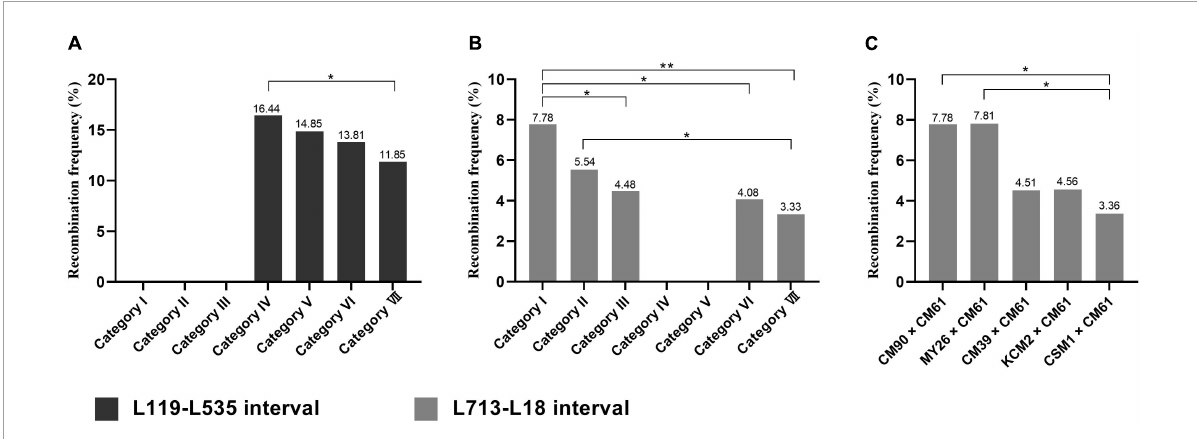
FIGURE4 Recombination frequency of 5A chromosome in L119-L535 and L713-L18 intervals. (A) Recombination frequency of 5A chromosome in L119-L535 interval. (B,C) Recombination frequency of 5A chromosome in L713-L18 interval. * p < 0.05, ** p < 0.01 (Chi-square test).